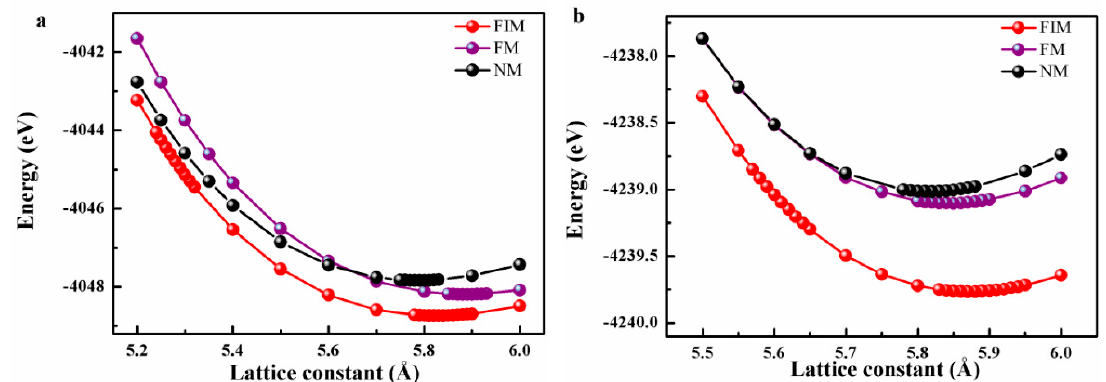
Figure 3. Energy optimization with different magnetic states of ( a ) FeRhCrSi and ( b ) FePdCrSi.